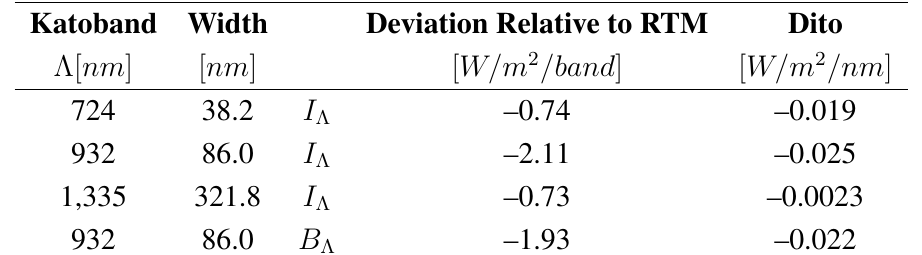
Table 1. Comparison of irradiance calculated with either RTM or the parameterization given in Equation (4) for the worst case scenario of 80 degree SZA and 70 mm water vapour content.